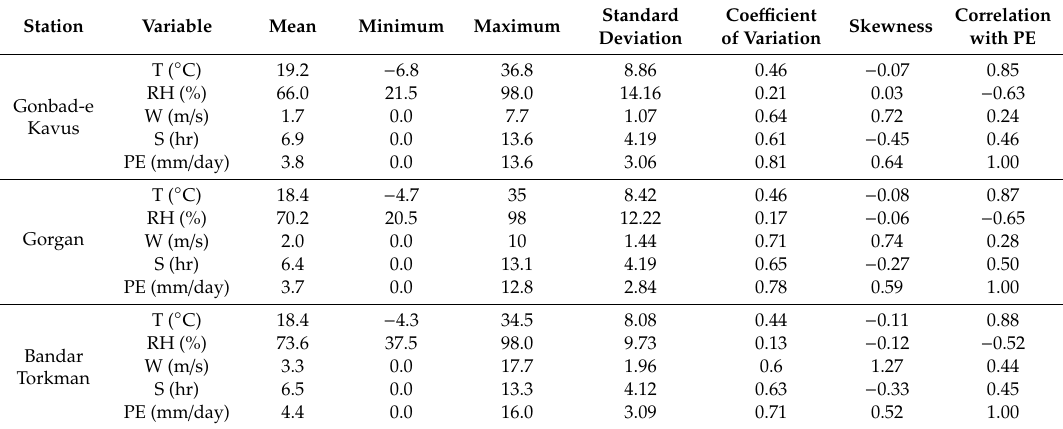
Table 1. Statistical characteristics of the utilized data in three studied